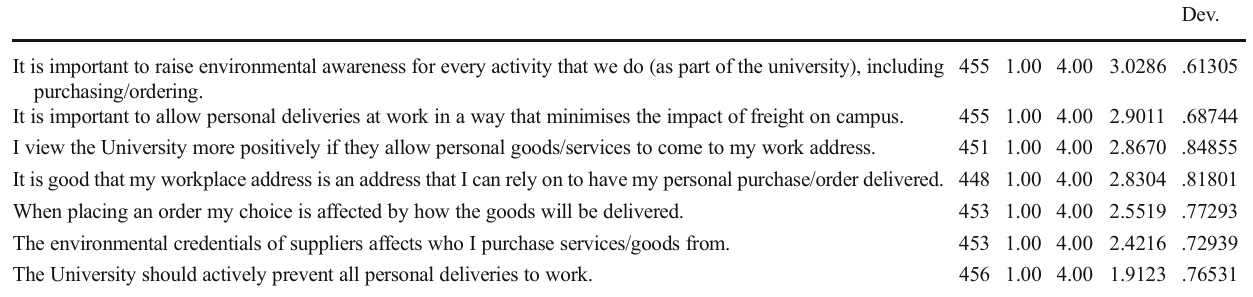
Statements measured on private purchasing behaviour (source: this study) Behavioural statements measured N Min Max Mean Std.